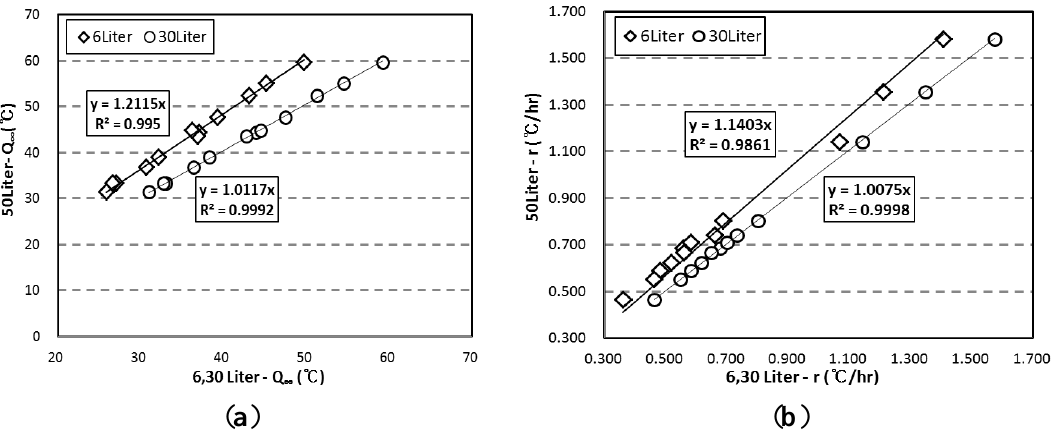
Figure 11. Correlation between the 6 L, 30 L, and 50 L adiabatic temperature rise test results for ( a ) maximum temperature rise; and ( b ) reaction